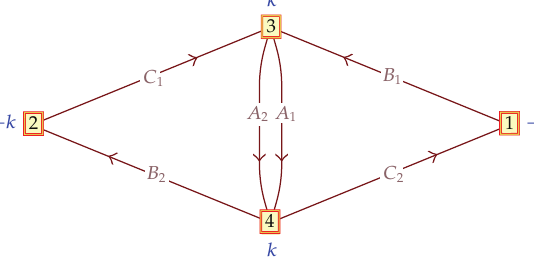
Figure 2: The toric diagram for C (cid:4) Q 111 (cid:5)